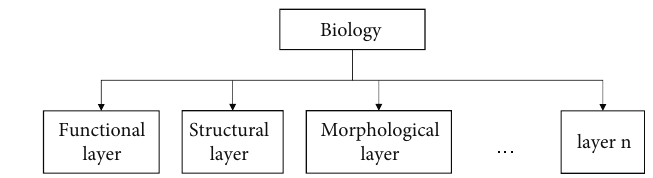
Figure 2: The multivariate coupling model.